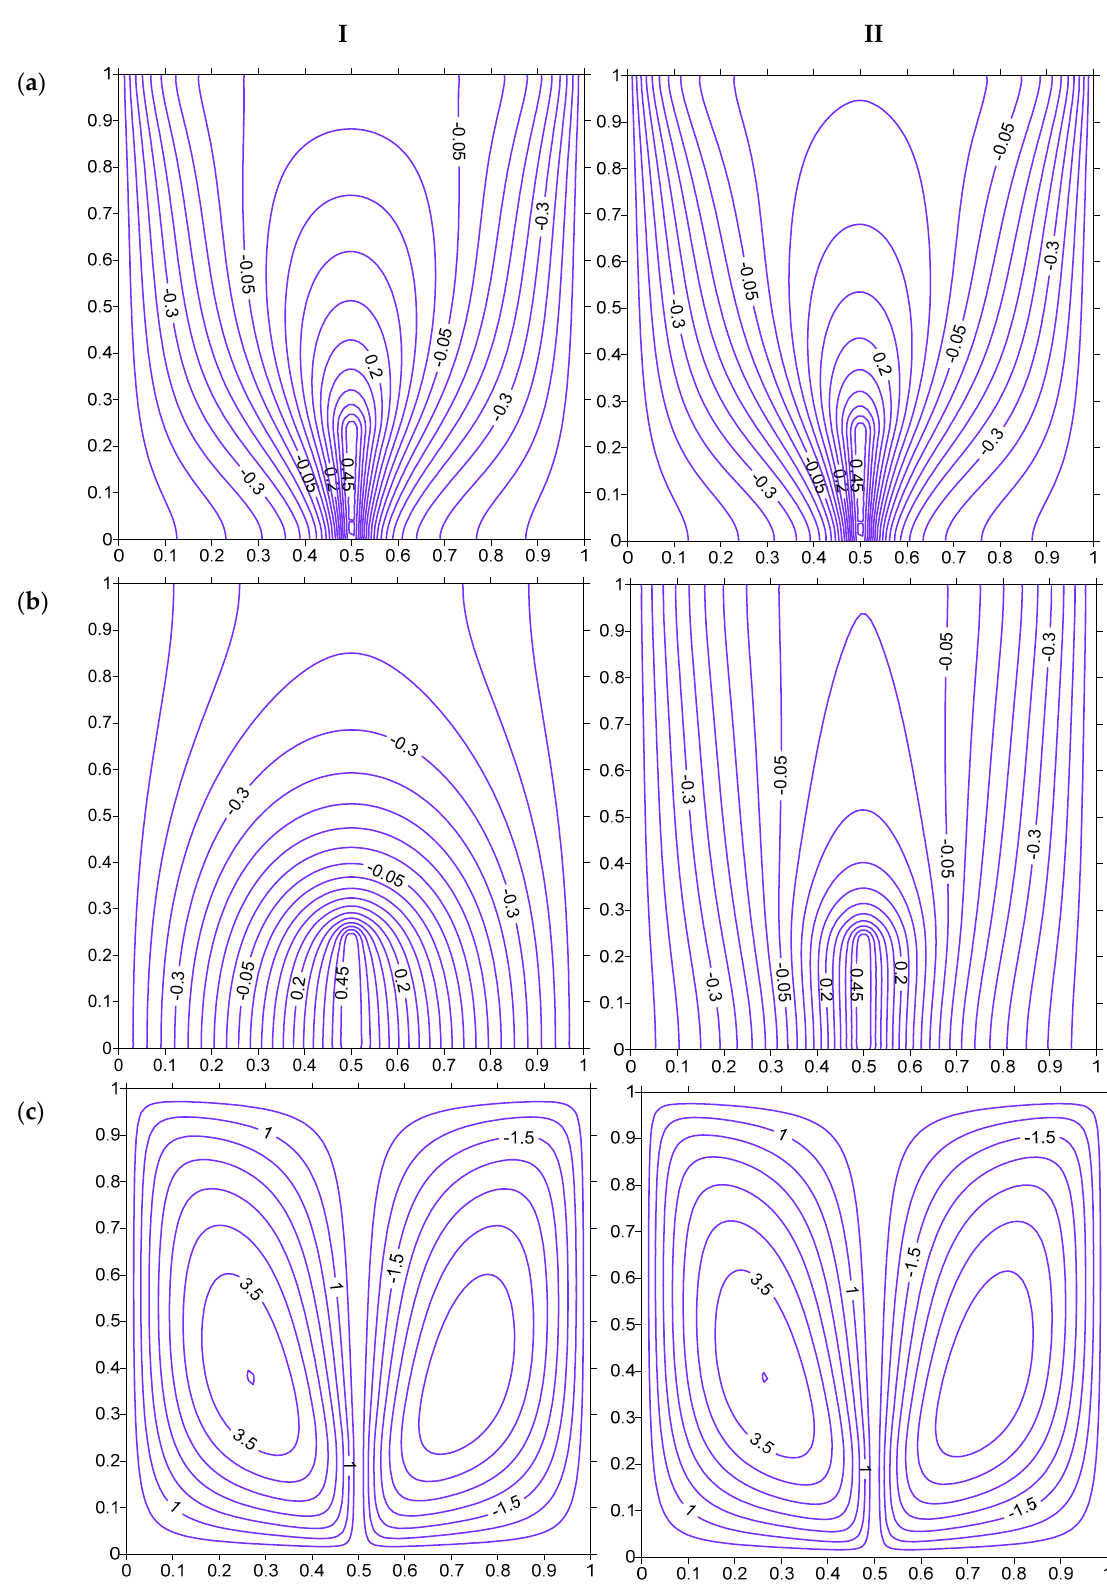
Figure 11. Isotherms (( a ) Fluid, ( b ) Solid), and streamlines ( c ), at Ra = 100 , HH = 25% , H = 5 , Rd = 0 for strip at x = 0.5. ( I ) Kr = 0.1. ( II ) Kr =